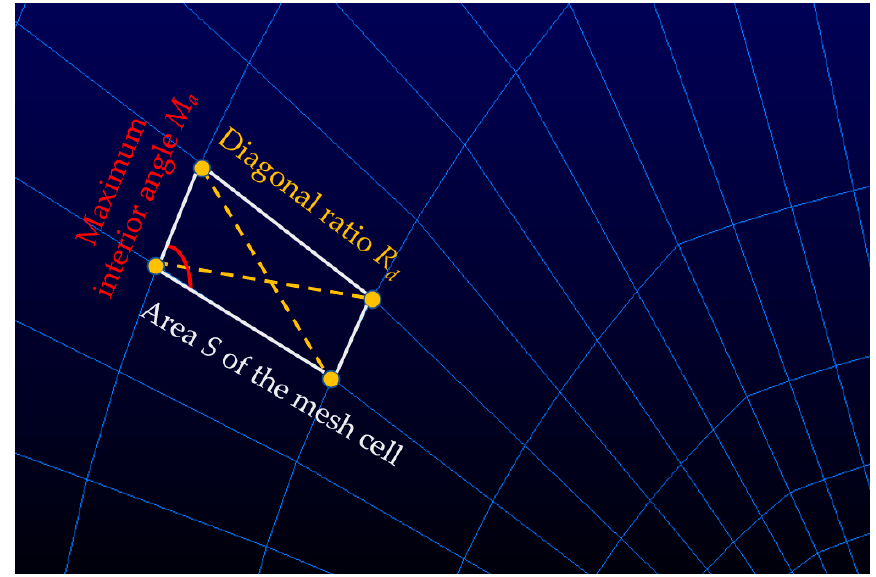
Figure 3. Features that represent the mesh.